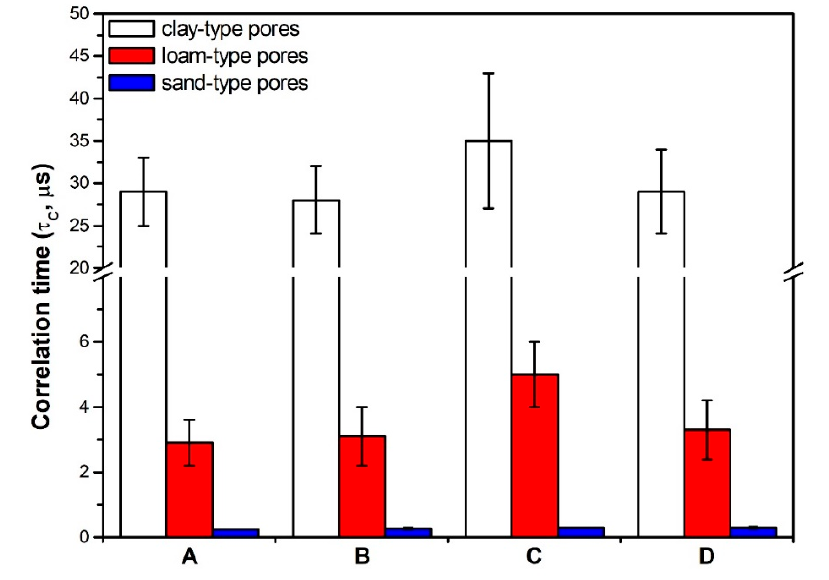
Figure 11. Correlation times obtained by applying a six-parameter free model analysis (Equations (10) and (11)) on the NMRD profiles for soils under A . Eucalyptus camaldulensis Dehnh., B . E. occidentalis Endl., C . Pinus halepensis Mill., and D . Cupressus sempervirens . The longest τ C value is due to water moving in clay-type pores. The shortest τ C value is related to water moving in sand-type pores. The intermediate τ C value is attributable to water moving in loam-type pores. The histogram has been built by using the data from Reference [62].